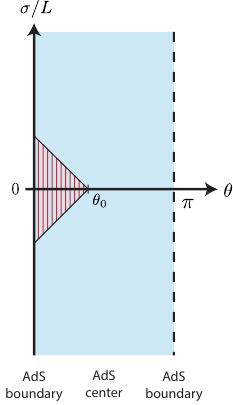
Figure 2 . The blue region corresponds to AdS 2 space-time represented in the ( (cid:27)=L; (cid:18) ) plane, with the two boundaries at (cid:18) = 0 ; (cid:25) . In red we see the region in which the bulk Killing vector (cid:24) (cid:22) (3.7) is time-like and therefore the extended (cid:12)rst law in (3.5)